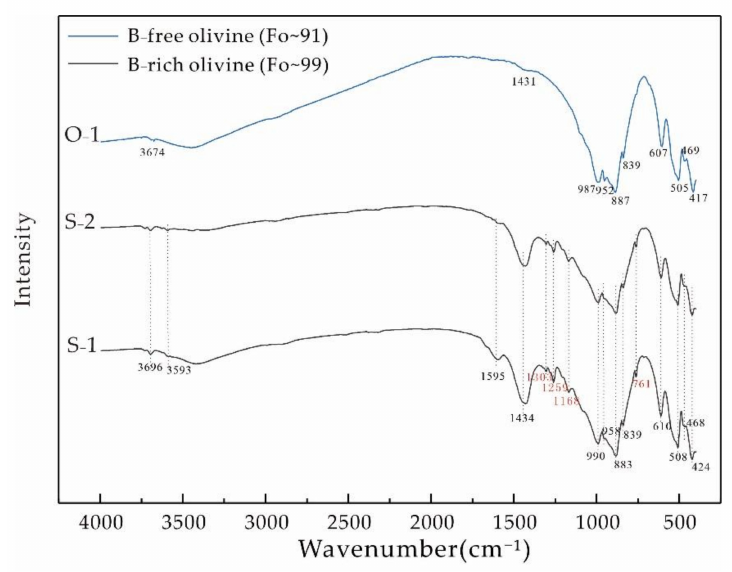
Figure 6. The infrared spectrum of B-rich forsterite compared with mantle